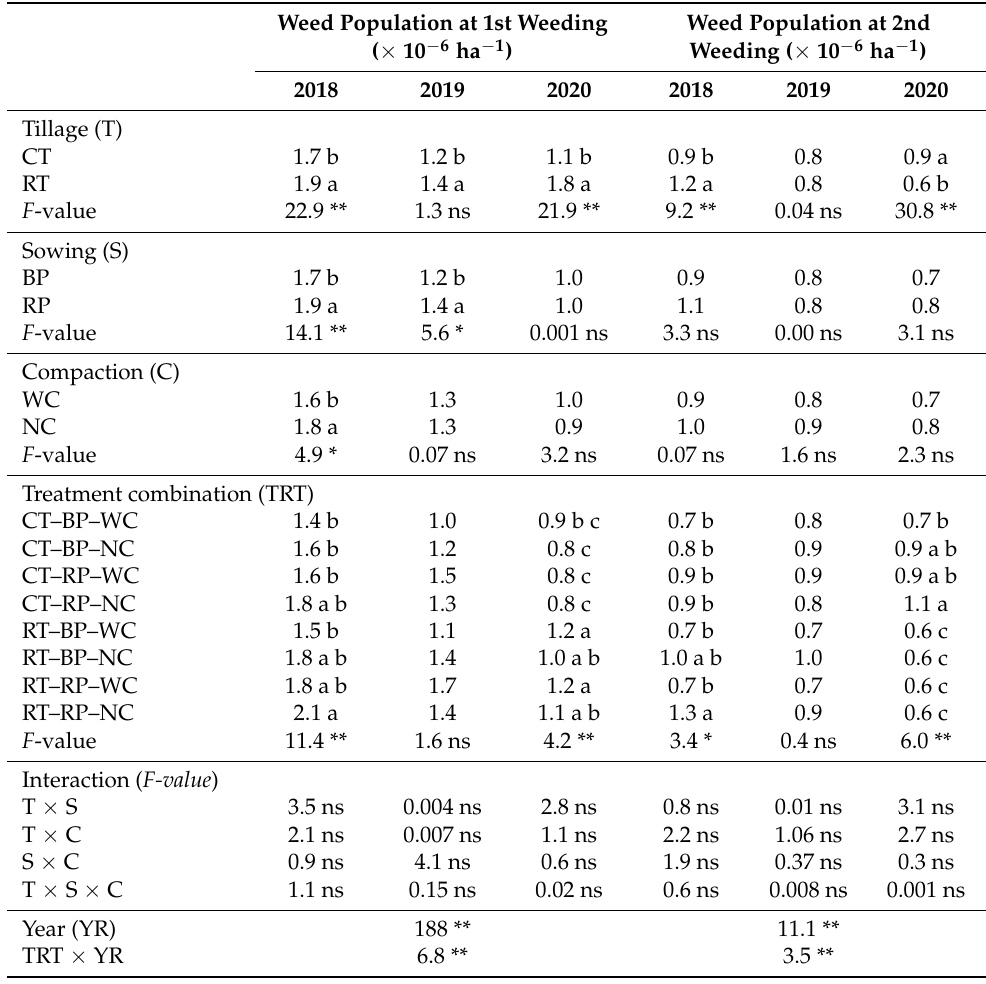
Table 5. Effects of tillage, sowing, and soil compaction methods on weed population at first and second weeding in 2018, 2019, and